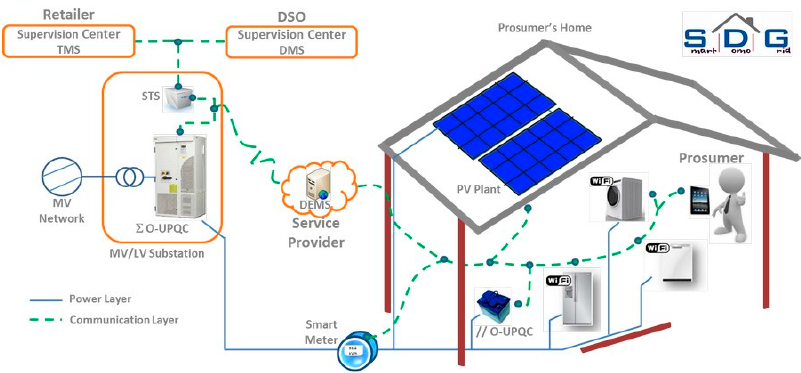
Figure 3. Structure of the test bed used in the Italian project Smart Domo Grid (http://www.serviziarete.it/progetto-smart-domo-grid-a2a/, last accessed January 2017) to monitor in real time the power exchanged between a customer and the electric grid in terms of active and reactive power, line frequency, voltage dips, and harmonic distortion.